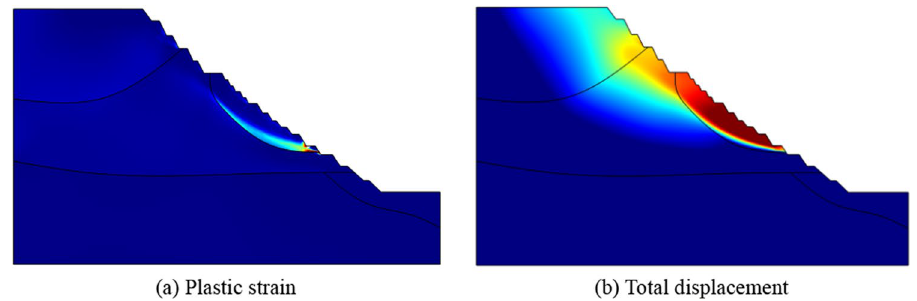
Figure 23. Distribution of plastic strain and total displacement at the initial time.